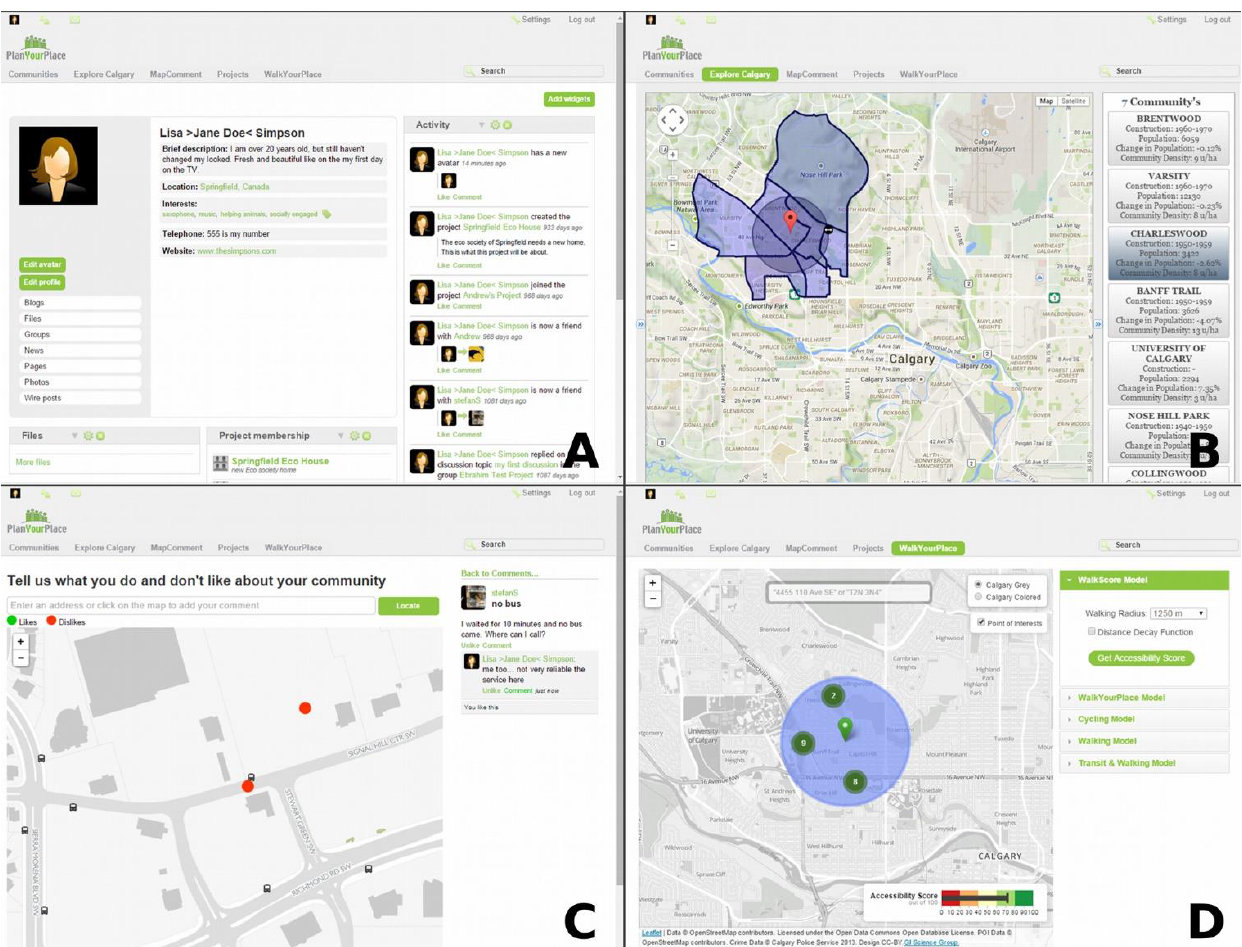
Figure 4. Screenshots of the e -planning platform prototype for PlanYourPlace.ca. Image A: user profile view; Image B: “Explore Calgary” a community information tool; Image C: “MapYourPlace” a community feedback tool; Image D: “WalkYourPlace” a tool to evaluate accessibility, here shown with www.walkscore.com concentric model with 1 mile walking